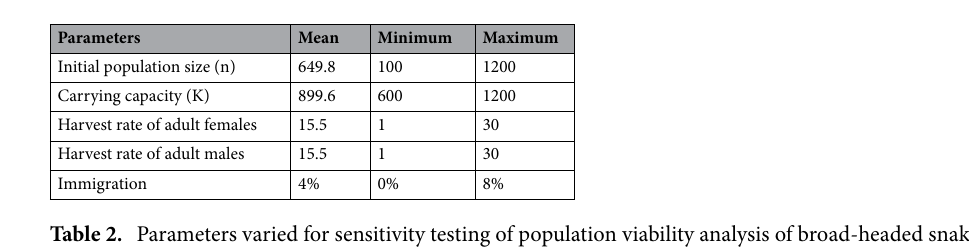
Table 2. Parameters varied for sensitivity testing of population viability analysis of broad-headed snake populations in Morton National Park, New South Wales, Australia.